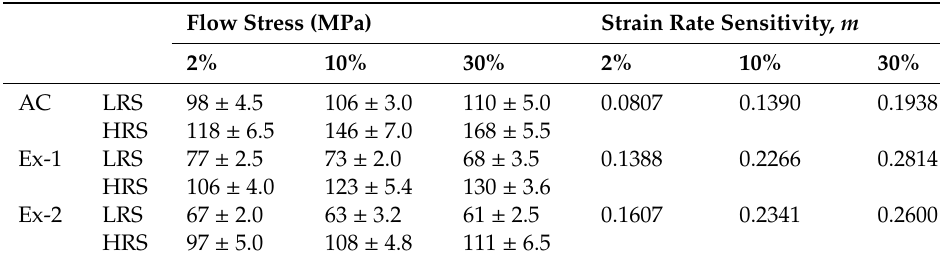
Table 1. The flow stress and strain rate sensitivity, m , of the three WE43 alloy materials at strains of 2%, 10%, and 30% when compressed at 400 ◦ C (LRS: low strain rate of 0.05 s − 1 ; HRS: high strain rate of 0.5 s − 1 ).